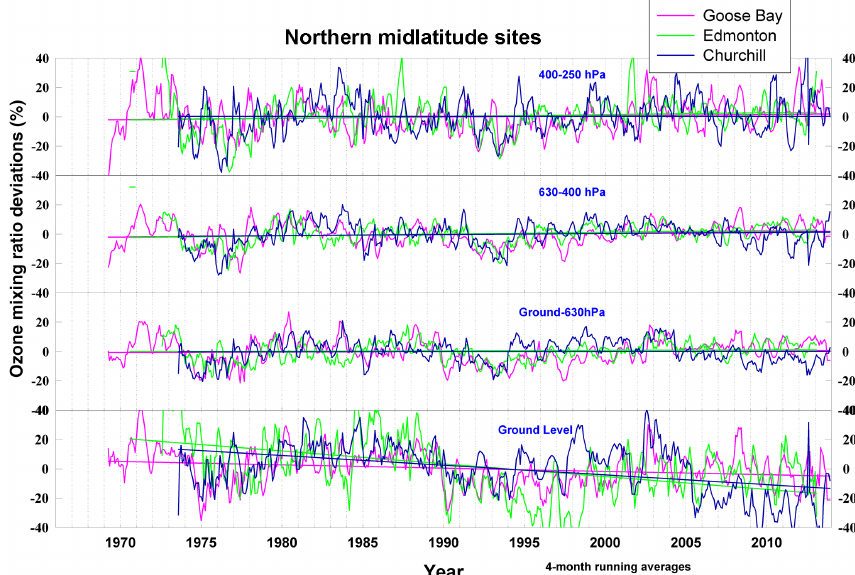
Figure 9. Percent deviations in average ozone mixing ratio for the surface and three tropospheric layers, for three midlatitude stations. Monthly anomalies have been smoothed with a 4-month running average. The overall station trend lines (up to 45 years in the case of Goose Bay) are shown. The troposphere and stratosphere have been explicitly separated; that is, integration for the 400–250hPa layer is from 400 to 250hPa or the tropopause, whichever comes first.